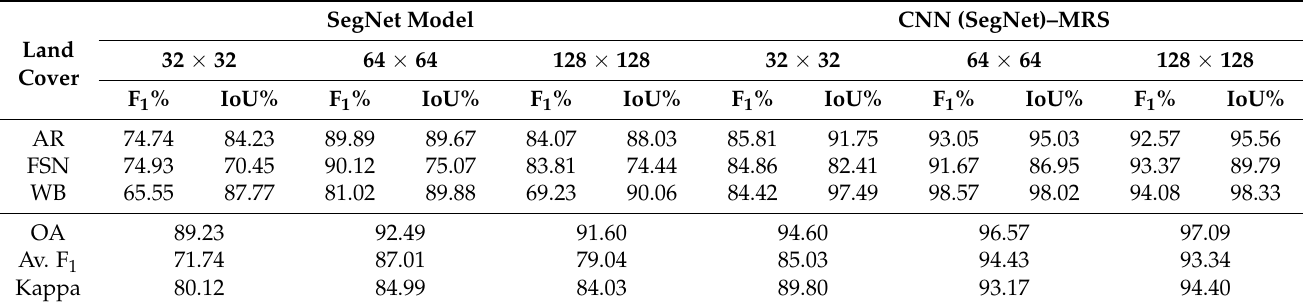
Table 9. Istanbul test site with 7 bands: performance metrics with